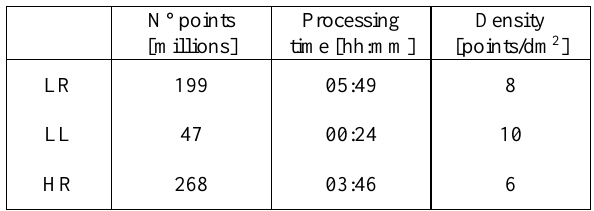
Table 6. UAV dense point clouds statistics .